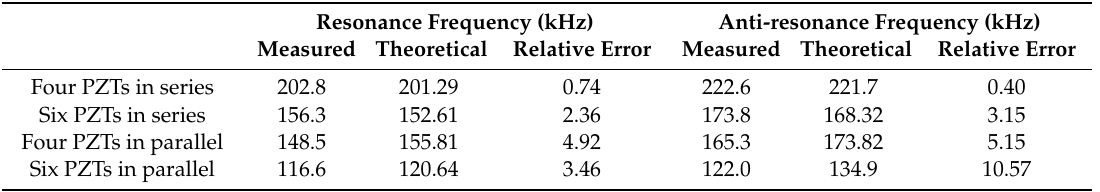
Table 3. Comparison of the first resonance and anti-resonance frequencies of